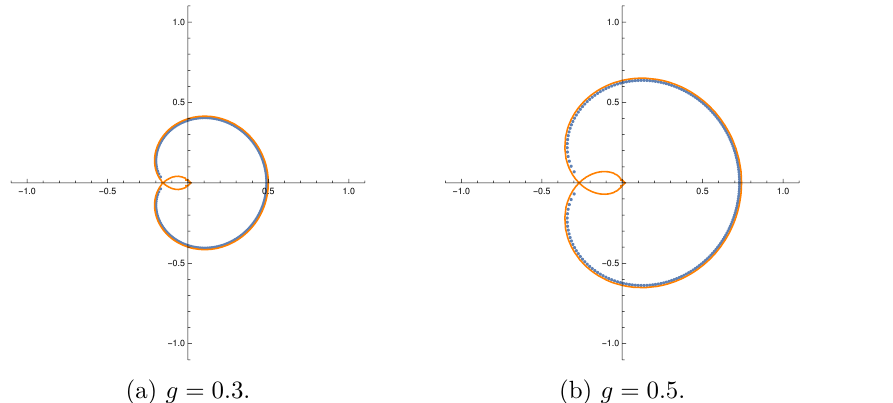
M 1 for N = 200 at (a) g = 0 : 3 and (b) 0 M 1 , while the orange curves represent the 0